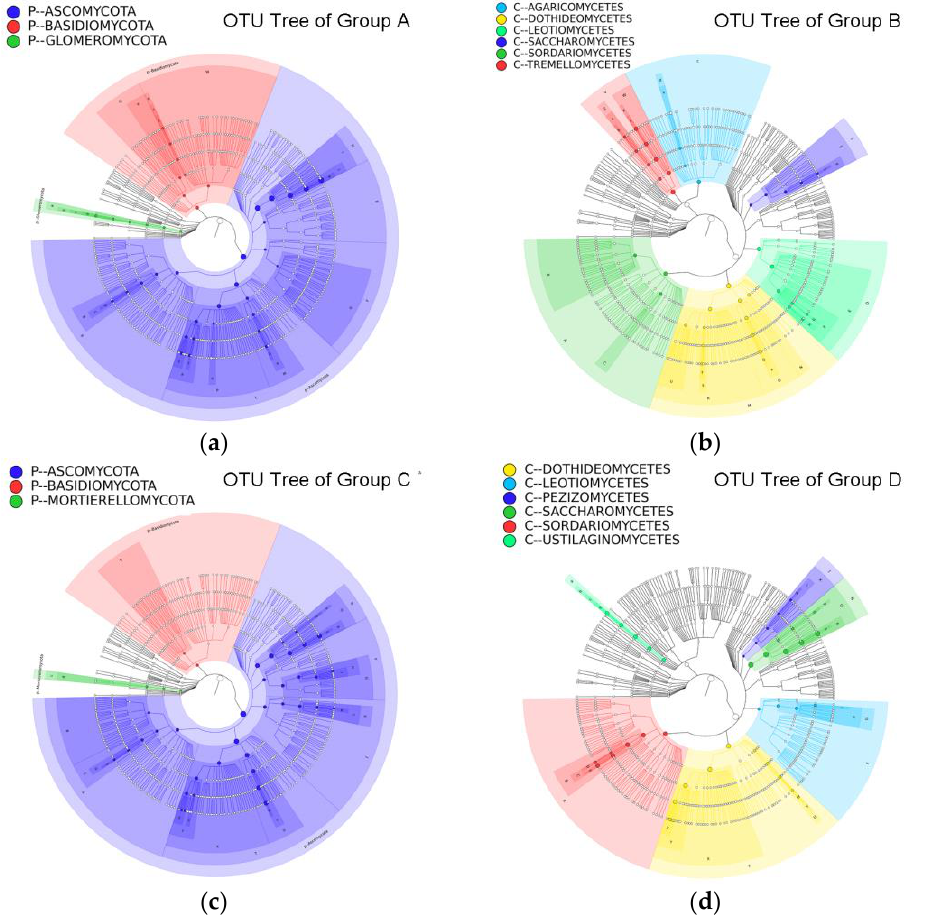
Figure 3. OTU annotation tree construct for each sample group (A – D), generated by ITS fungal region, in ( a – d ) respectively. Different taxonomic ranks range from inside out. Size of circles stands for abundance of species. Different colors stand for different phyla. Solid circles stand for the top 40 species in high abundance. Full-size constructs are provided as supplementary material.